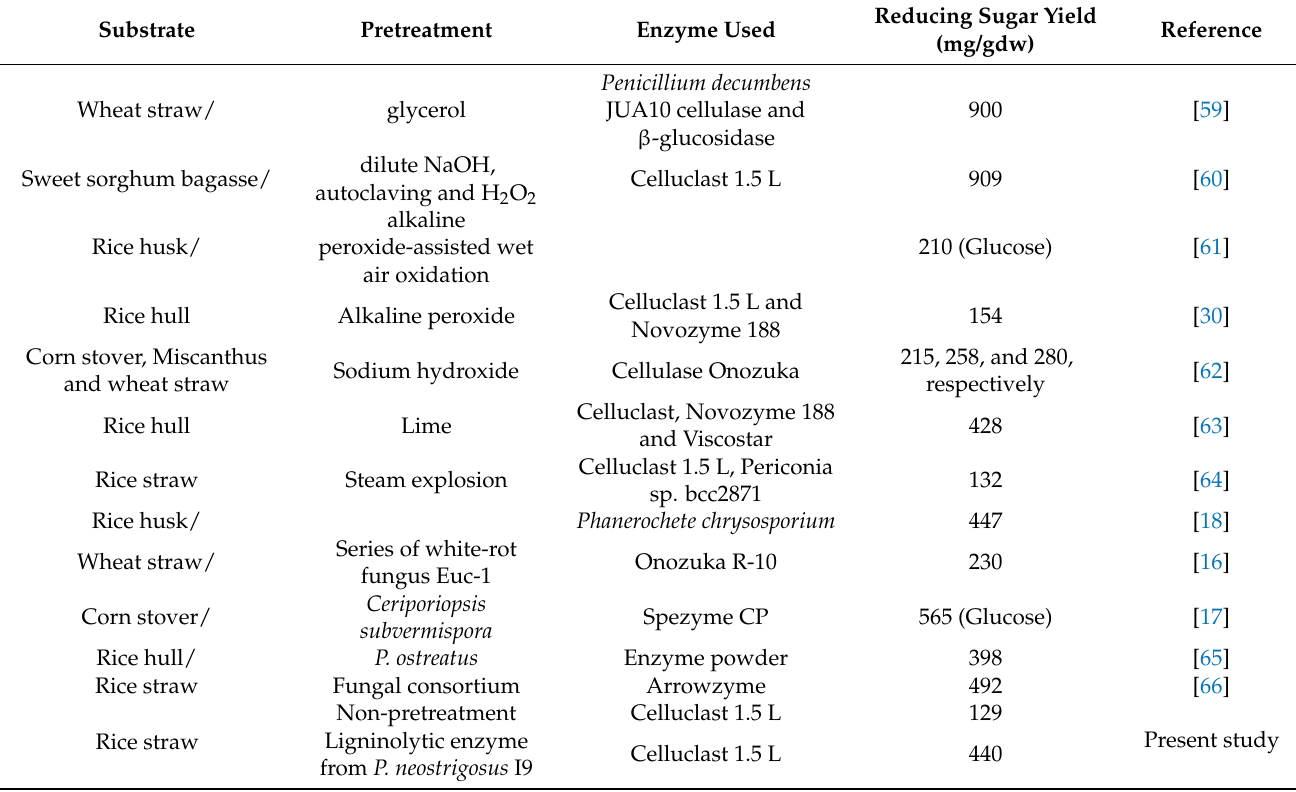
Table 9. Various studies on reducing sugar production from lignocellulosic